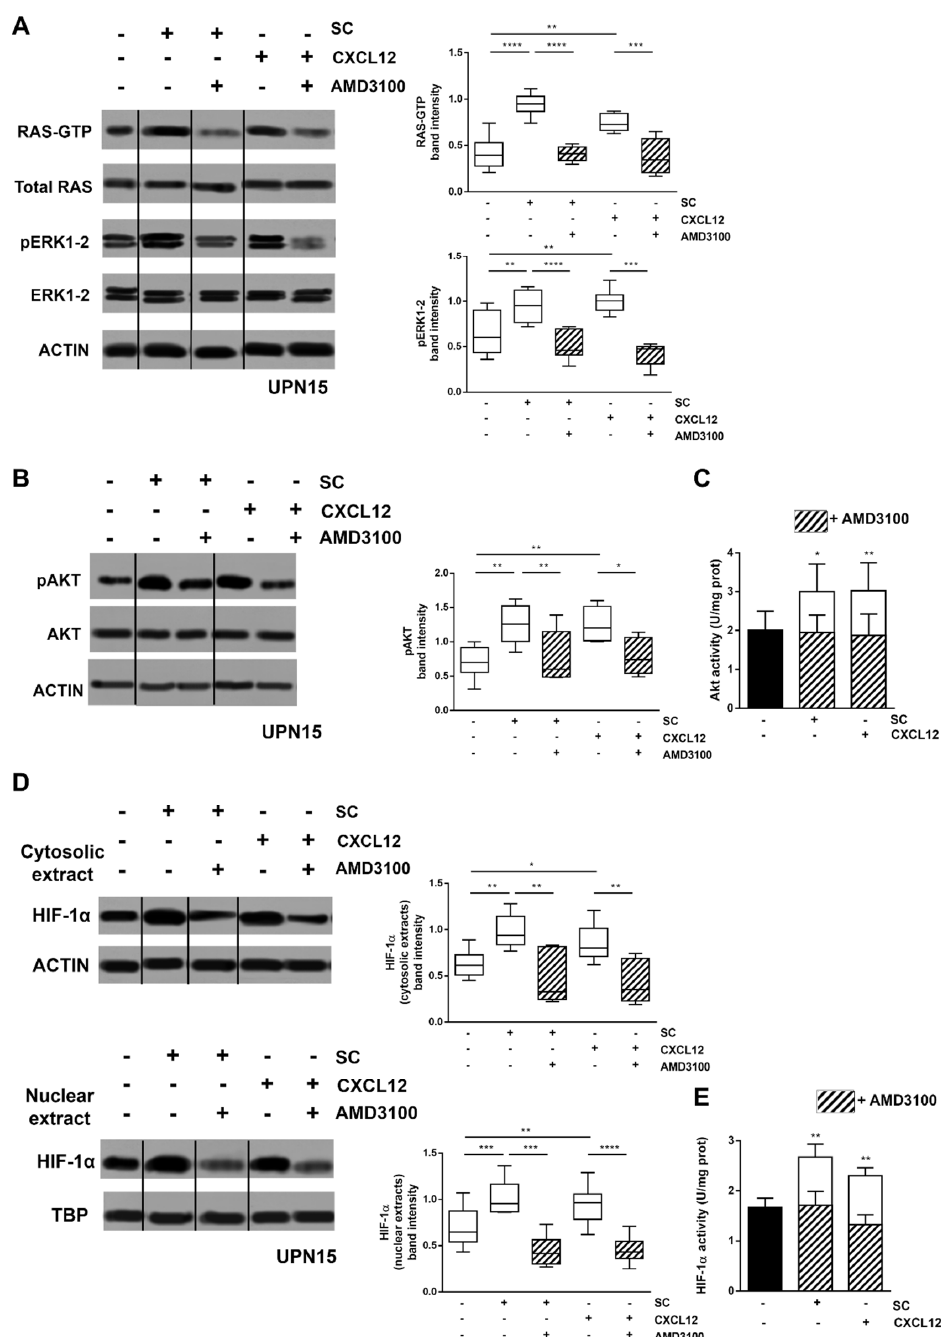
Figure 1. The CXCL12/CXCR4 axis plays a central role in the SC-mediated triggering of HIF-1 α regulatory pathways. Primary CLL cells were cultured for 48 h in presence of M2-10B4 SC or CXCL12. In selected conditions, the CXCR4 antagonist AMD3100 was added. Both SC and CXCL12 induced an increase in the amount of GTP-bound RAS (RAS-GTP) and of the active phosphorylated form of ERK1-2 (pERK1-2) ( A ), and in the phosphorylation and activity of AKT ( B , C ). Accordingly, CLL cells cultured with SC or CXCL12 displayed an increase in the cytosolic and nuclear amount of HIF-1 α ( D ), and in HIF-1 α activity ( E ). The addition of the CXCR4 antagonist AMD3100 abrogated the inducing effects mediated both by SC and CXCL12 at all levels. In ( A , B , D ) a representative blot (with relative Unique Patient Number, UPN), together with the corresponding cumulative band intensity data of 6 independent experiments, respectively, is shown. Box and whiskers plots show median values, 25–75% percentiles, and minimum and maximum values for each group. In ( C , E ) bar graphs represent mean results and SEM ( n = 6). Repositioned gel lanes are indicated by vertical lines. **** p < 0.0001, *** p < 0.001, ** p < 0.01 and * p < 0.05. Please find the whole western blot in the Supplementary File